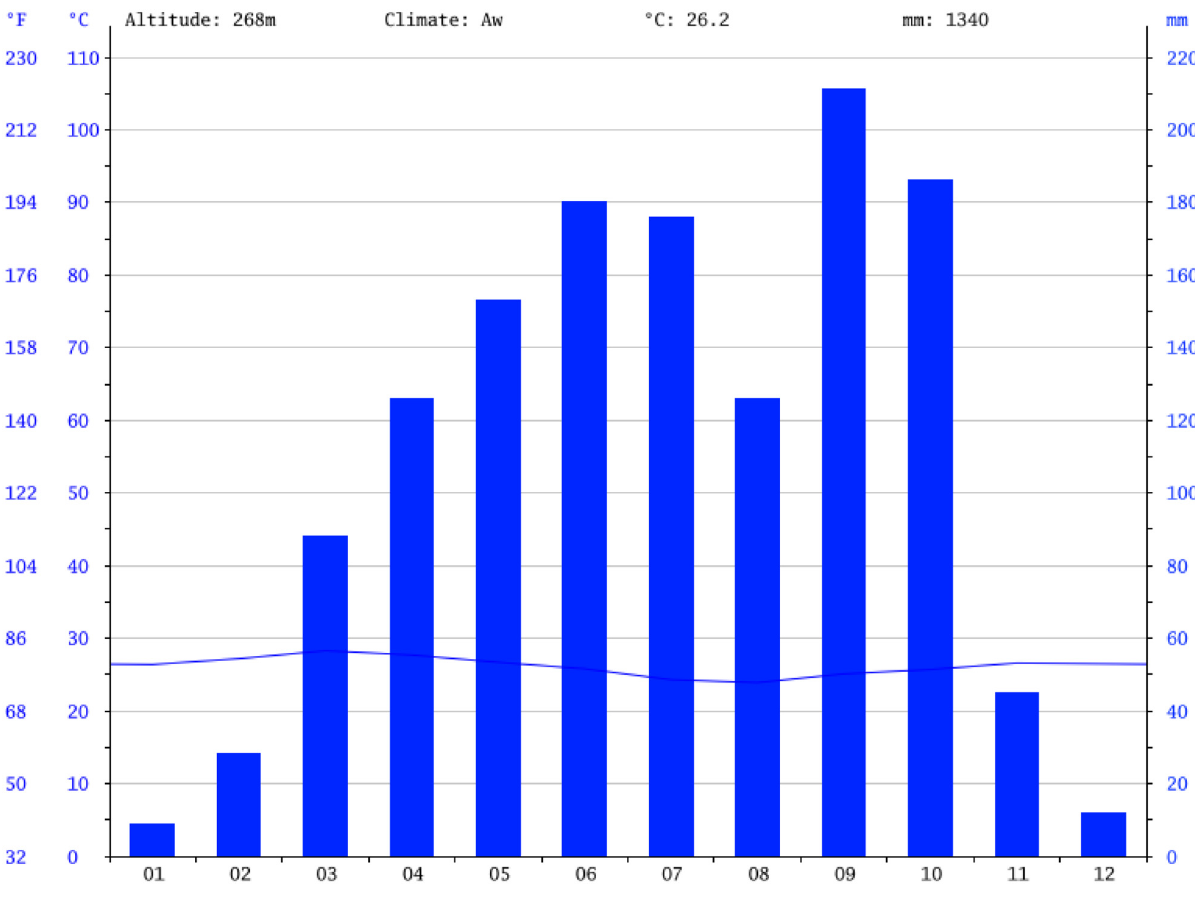
Fig. A1. Weather chart of Ile-Ife for a typical year. Source :